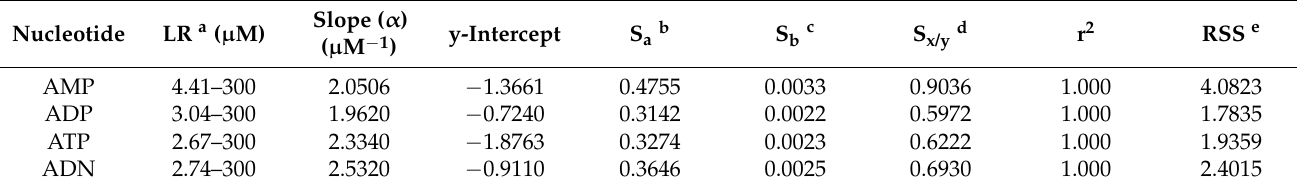
Table 1. Linearity parameters for adenylate standards determined by ion-pair RP